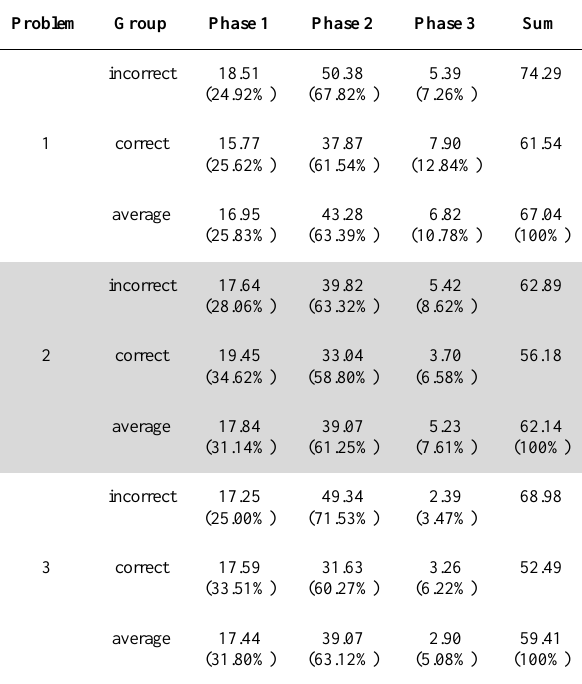
Average total fixation duration (in seconds) in each phase and the percentage in a